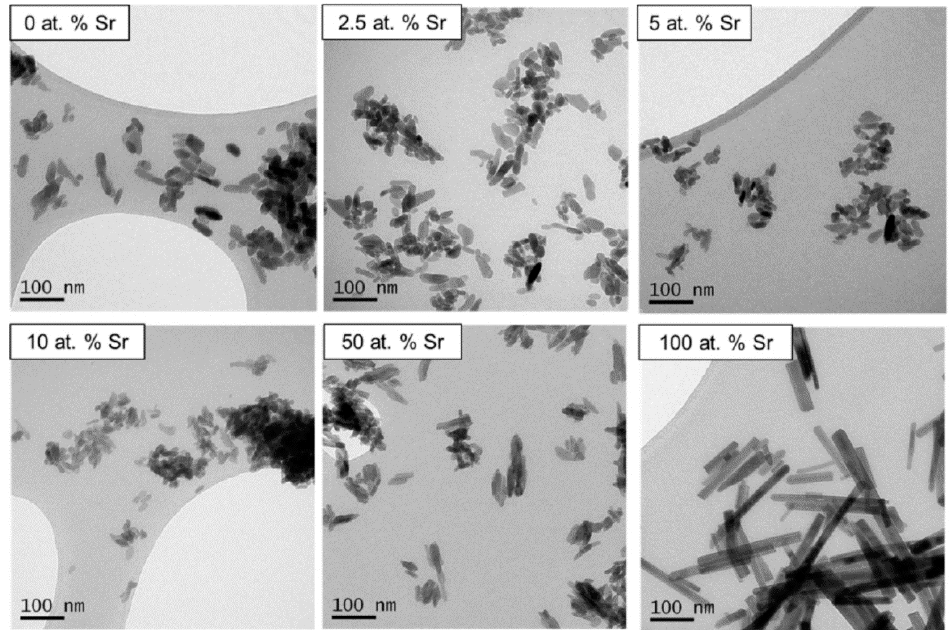
Figure 3. TEM micrographs of unsintered SrHA powders (0, 2.5, 5, 10, 50 and 100 at.% Sr) produced using the sol-gel